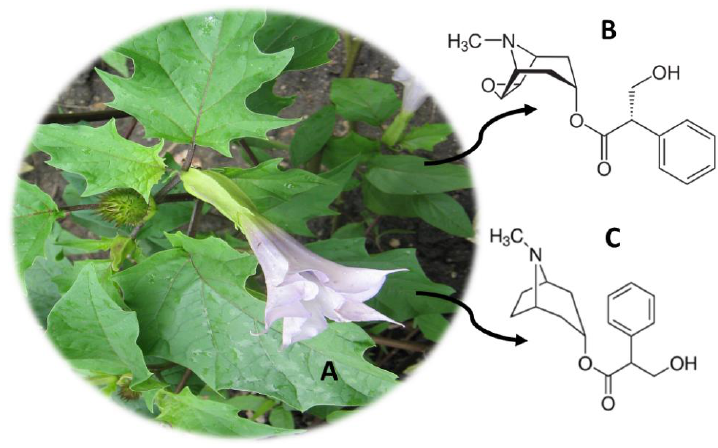
Figure 5. Datura stramonium ( A ) and the main compounds scopolamine ( B ) and atropine ( C ).